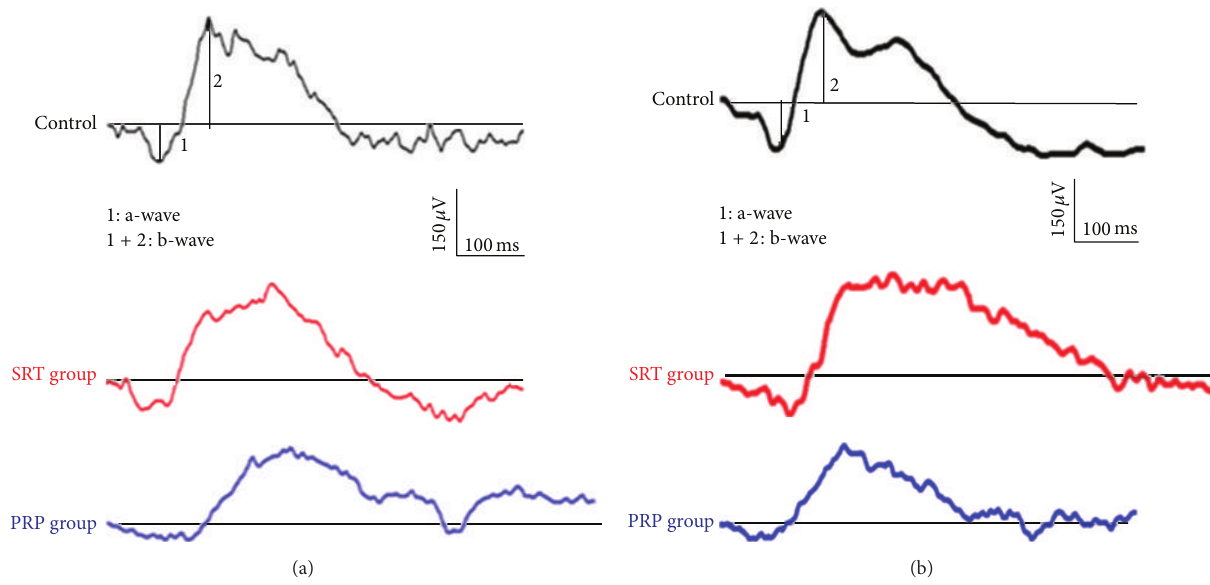
Figure 3: Dark-adapted ERG in the control group (top). ERG responses in the SRT groups were not significantly different from those of the control groups at either 1h or 3 weeks after irradiation. (a, b, middle) However, the amplitudes of the conventional PRP group were significantly lower at these two time points (a, b, bottom).